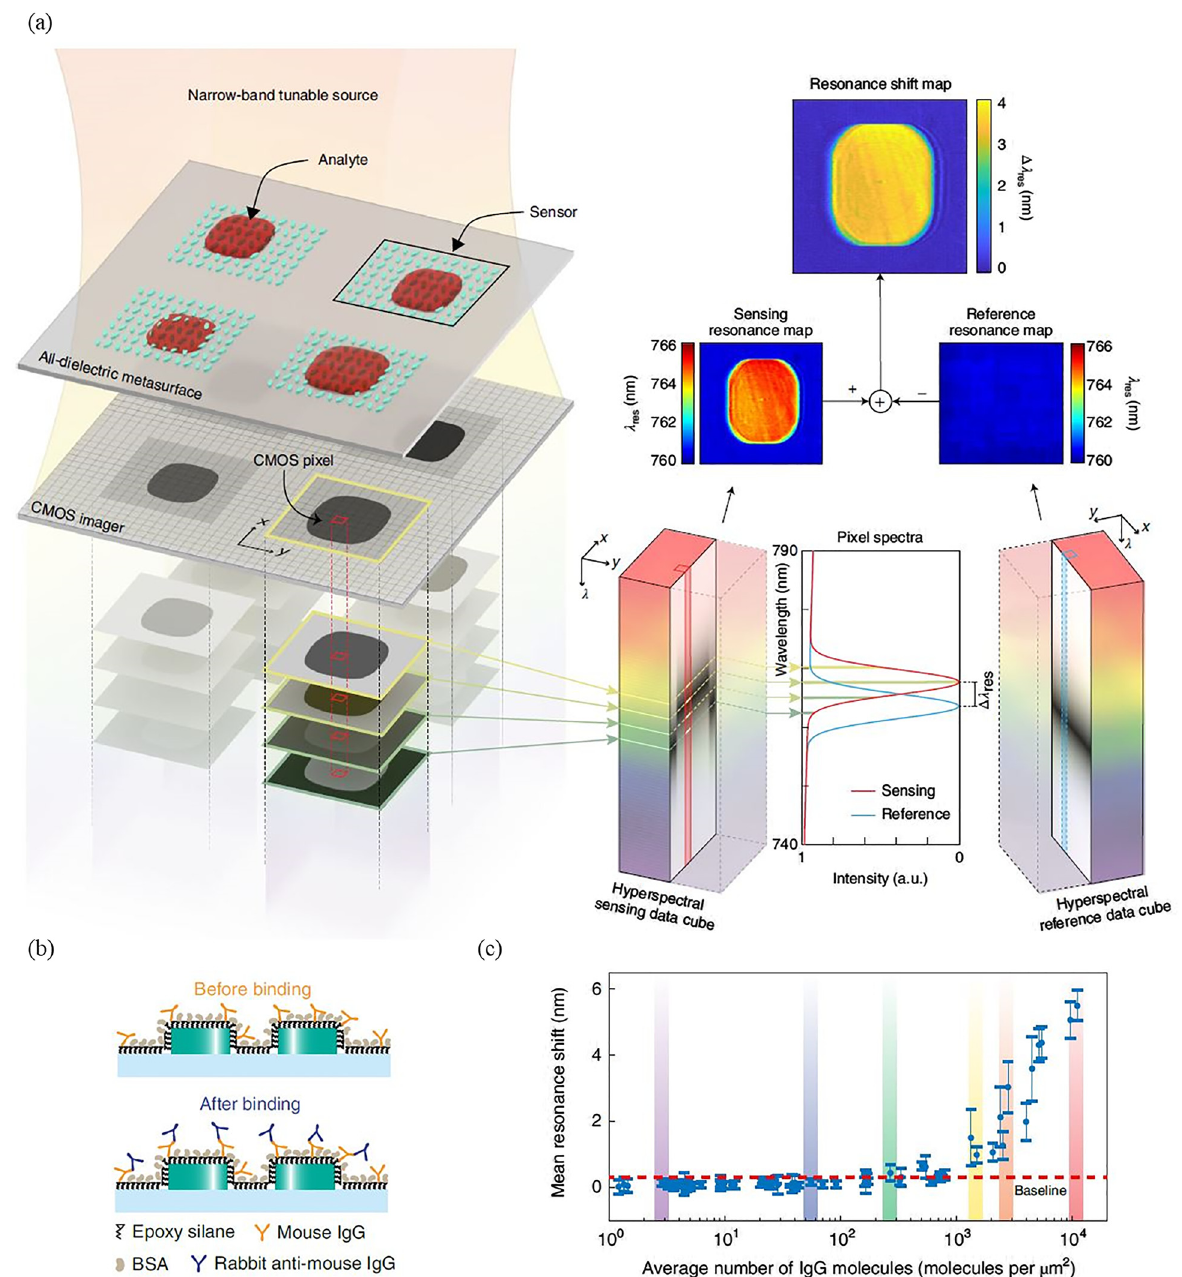
Figure 8: Dielectric metasurface-based hyperspectral imaging for ultrasensitive biomolecule detection. (a)Schematicofdielectricmetasurface-integratedCISforhyperspectralimaging-basedbiosensing.Narrow-bandtunablelasersourceisused forillumination.CMOScameracapturesimageforeachwavelengthandthedataformshyperspectraldatacube.Foreachpixel,theresonance wavelengthcanbeobtainedfromtheprocessedspectralinformation.Biosensingisachievedbycomparingtheresonancemapofmetasurface with biomolecules and the reference resonance map without the biosample. (b) Schematic showing the immobilization process of the biomolecules for sensing purpose. (c) Mean resonance shift with respect to average number of IgG molecules. (a) – (c) are adapted with permission from Springer Nature, Nature Photonics [67]. Ultrasensitive hyperspectral imaging and biodetection enabled by dielectric metasurfaces, Yesilkoy, et al. Copyright which is opaque in visible wavelength, but transparent in and right panel, respectively. From the IR image, the IR range. The images obtained by the system in visible and donut-shaped object can be observed. For comparison, IR wavelength range are shown in Figure 9(e) middle the image taken by a conventional camera in visible